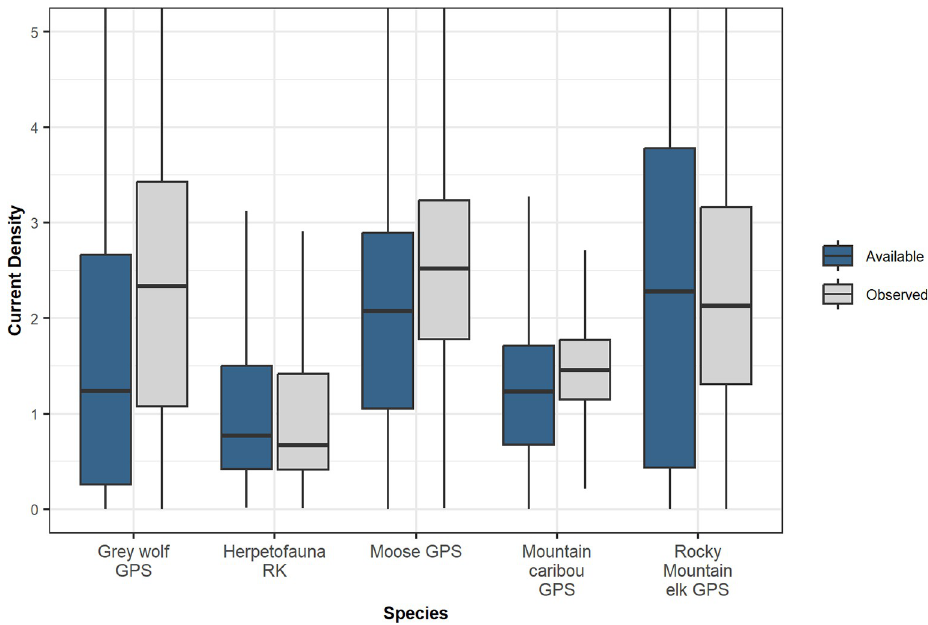
Fig 5. Comparison of current densities at observed GPS locations versus available, but unused locations. Boxplots depict median current density (thick horizontal line) and the central 50% of current density values (boxes) for observed wildlife locations and available, but unused locations. Extreme values were omitted from the figure for visualization purposes. GPS = data collected from GPS collars; RK = roadkill data.